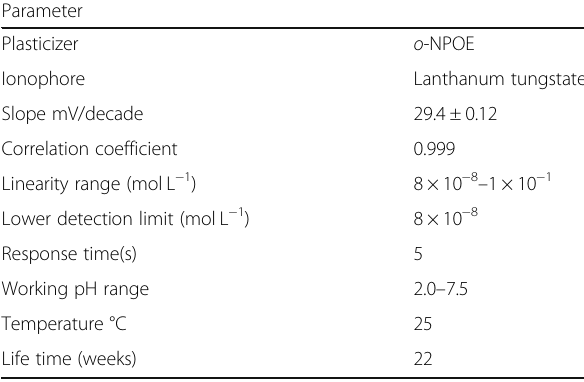
Table 5 Response characteristics of Cd(II)-CPE sensor